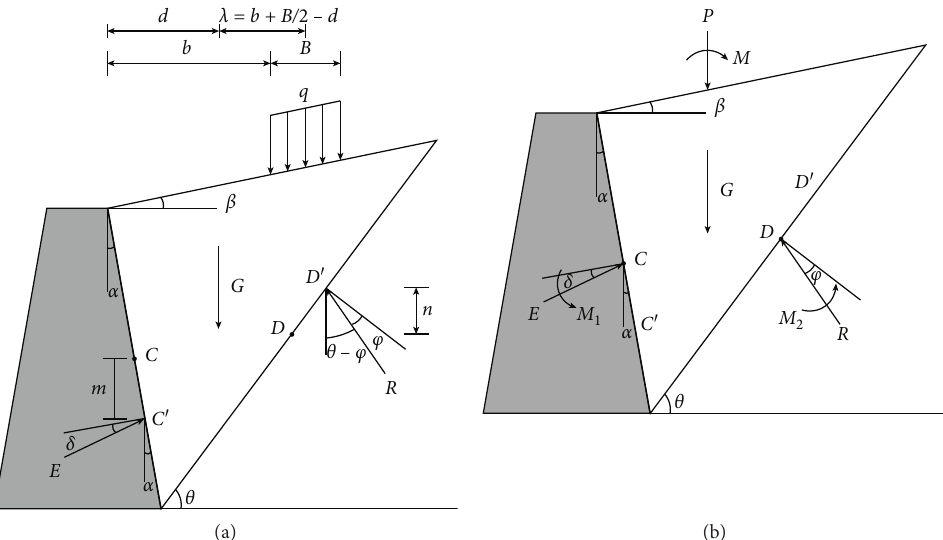
Figure 1: The midpoint of strip loading is on the right of the backfill gravity center. (a) Physical model. (b) Equivalent moment model.